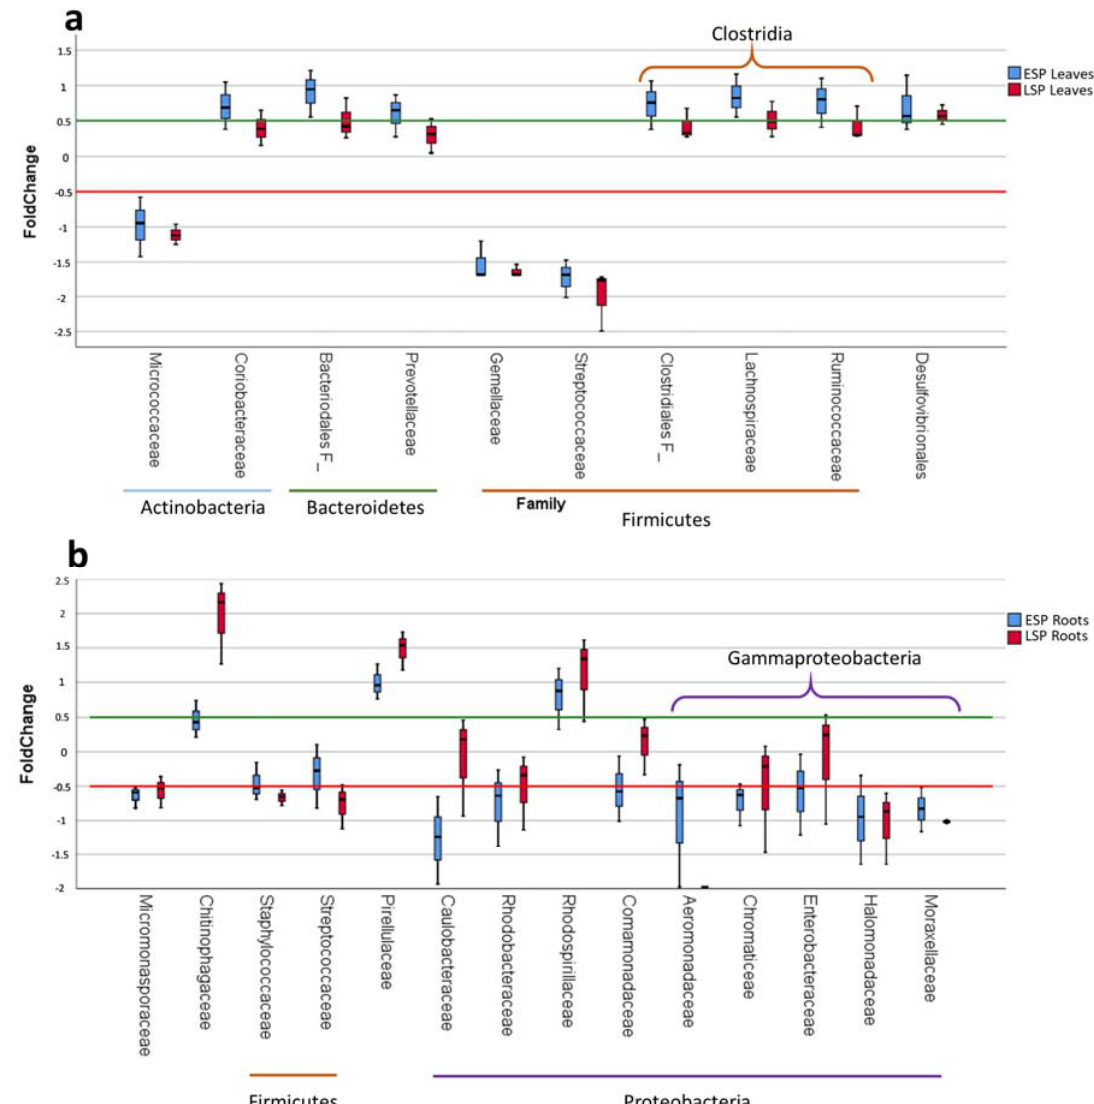
Figure 5. Box plots reporting the shift in absolute abundance of relevant taxonomical families in ESP and LSP samples compared to the ASP. Difference in abundance is expressed as fold change in a logarithmic scale (base 10). Median values above 0.5 or above − 0.5 were considered relevant differences. ( a ) box plot showing the differences in leaves, highlighting with lines at the bottom families belonging to the same phylum , and with brackets on top those belonging to the same order; ( b ) box plot showing the differences in roots, highlighting with lines at the bottom families belonging to the same phylum , and with brackets on top those belonging to the same class.